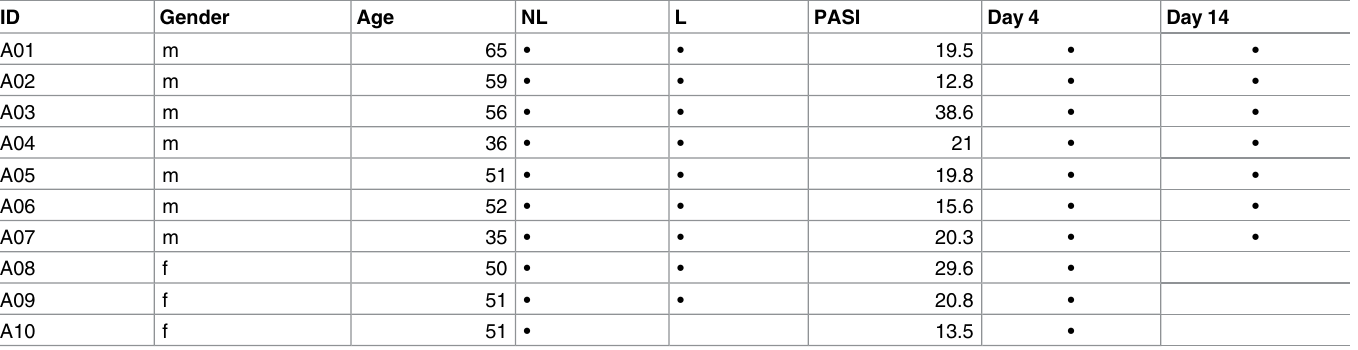
Table 1. Details on patients included in the study. Paired punch biopsiesfrom ten psoriasispatients were used. Gender, age and Psoriasis Area and Severity Index (PASI) score are given for each patient; mean age = 50.6 years, mean PASI = 21.15. Available biopsy samples(NL, L, Day 4 and Day 14) are indicatedwith